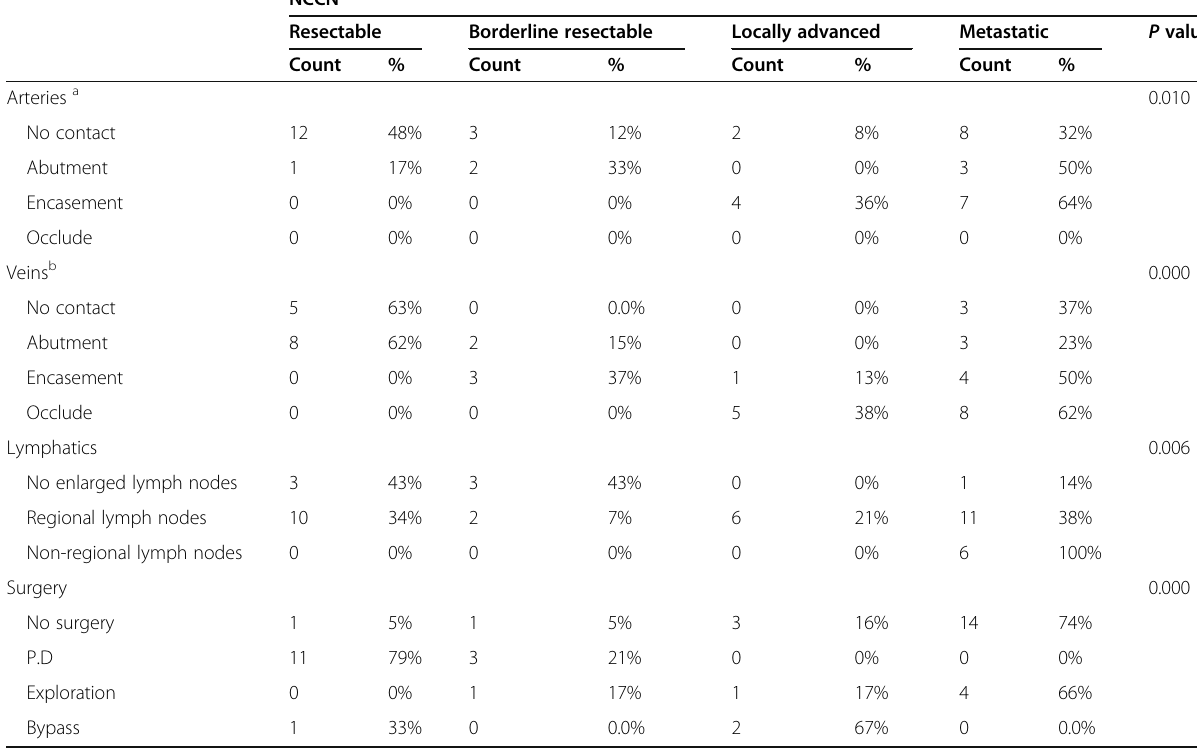
Table 6 Degree of arterial, venous, and lymphatic involvement in comparison to MDCT resectability